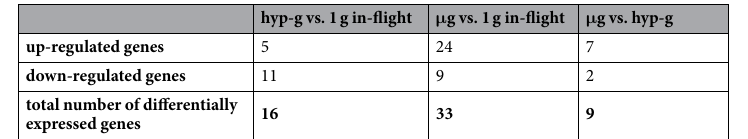
Table 4. Differentially expressed annotated genes in T cells during the 23 rd Parabolic Flight Campaign. Number of annotated significantly differentially expressed genes that are included in only one comparison after elimination of differentially expressed genes due to hardware effects (hardware 1 g ground control compared to the cell culture control) and 1 g in-flight effects (1 g in-flight control compared to the hardware 1 g ground control). hyp-g: hypergravity samples, μ g: microgravity samples. Fold change ± 1.3, p <